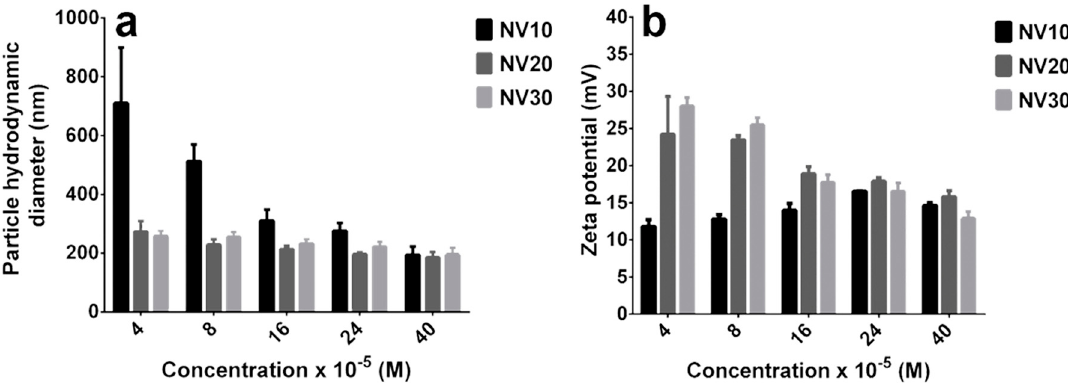
Figure 3. Particle hydrodynamic diameter of NV10, NV20 and NV30 at various concentrations ( a ). Zeta potential of NV10, NV20 and NV30 at various concentrations ( b ). The utilized concentrations were calculated reporting to bPEI800 weight from dynamic frameworks aqueous solutions.